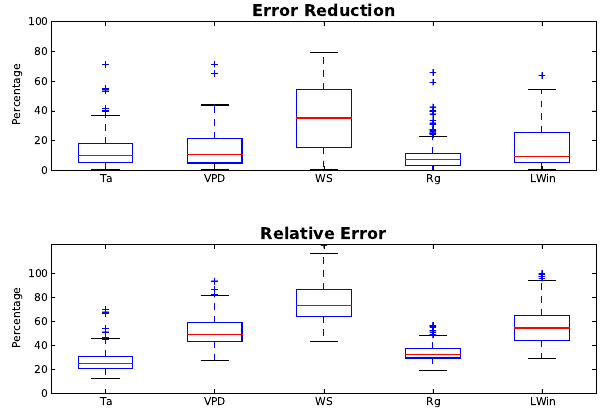
Figure 1. Distribution across sites of the error reduction (top panel) and relative error (bottom panel) of the bias correction method for air temperature, vapour pressure deficit, wind speed, global radia- tion and longwave incoming radiation. The box extends from the lower (25%) to upper quartile (75%) values of the data, with a red line at the median. The whiskers extend from the box to show the range of the data within 1.5 (25–75%) data range. Outliers are × marked by crosses beyond the end of the